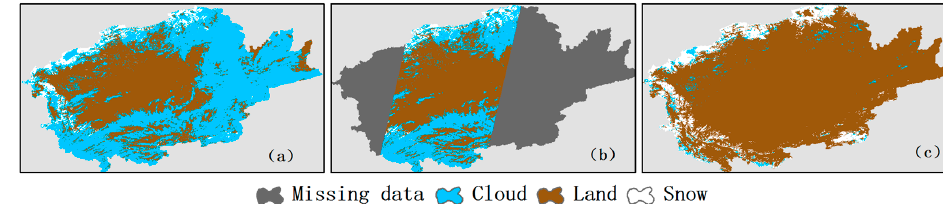
Figure 7. Maps of: ( a ) original MOD10A1 data; ( b ) original data after removal of pixels with large sensor zenith angle (SZA) values; and ( c ) modified data produced by multiday refilling for the Tarim River Basin.